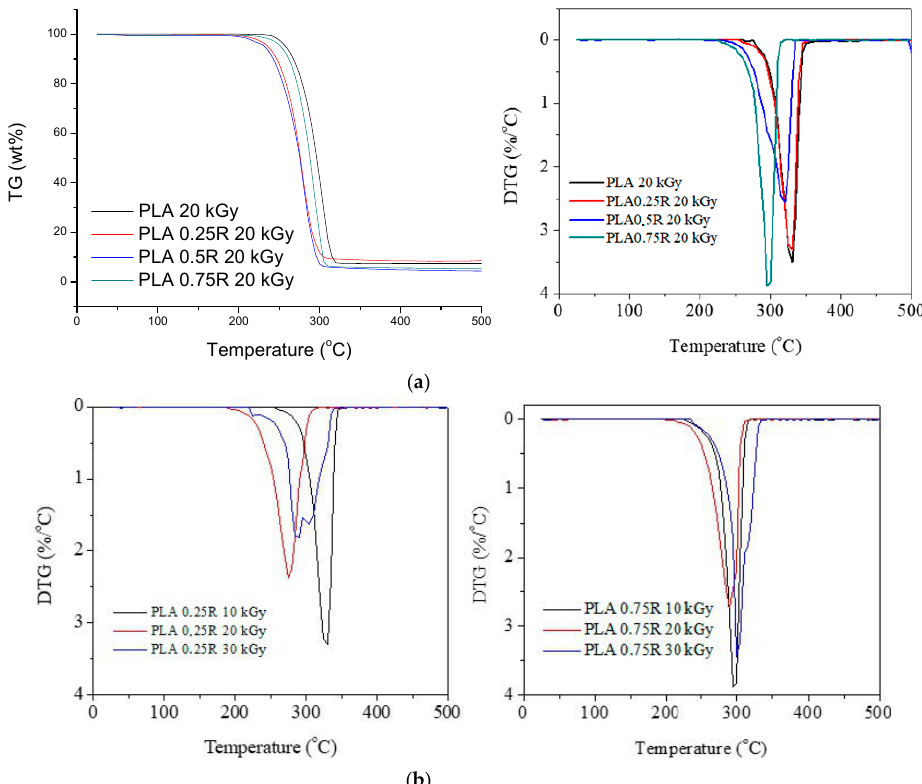
Figure 8. TG/DTG curves of the PLA/R blends with different R content irradiated with a gamma dose of 20 kGy ( a ); DTG curves of the PLA/0.25R and PLA/0.75R at different gamma irradiation doses ( b ).